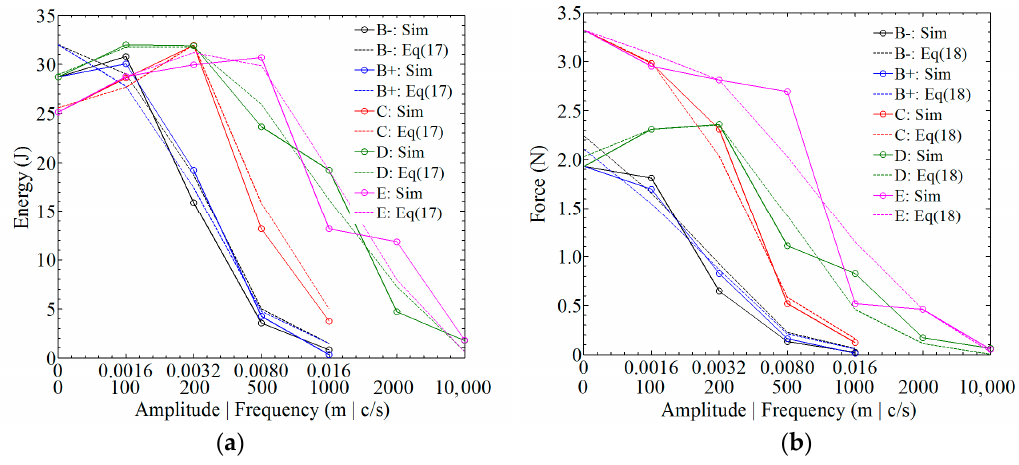
Figure 20. A comparative study of the statistical results and the simulation results: ( a ) E t = 0.01 ; ( b ) F avg .